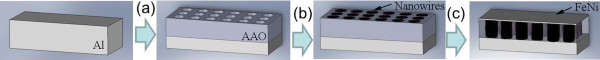
Preparation of the heterogeneous nanobrush based on the AAO templates and magnetron sputtering. (a) A regular AAO template was achieved by two-step oxidation; (b) Fe, Co, or FeCo alloy nanowires were deposited by alternating current; (c) a nanoscale film covered the surface by magnetron sputtering (the AAO template was hidden in this sketch).